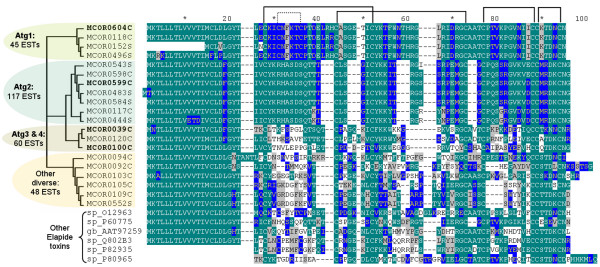
Alignment of translated 3FTx clusters from M. corallinus transcriptome (MCORs) and from other Elapidae species (referred by accession numbers). Sequences can be organized in different groups, as emphasized by a Neighbor Joining tree on the left, from which some clusters were selected (bold) to be used in the DNA immunization.